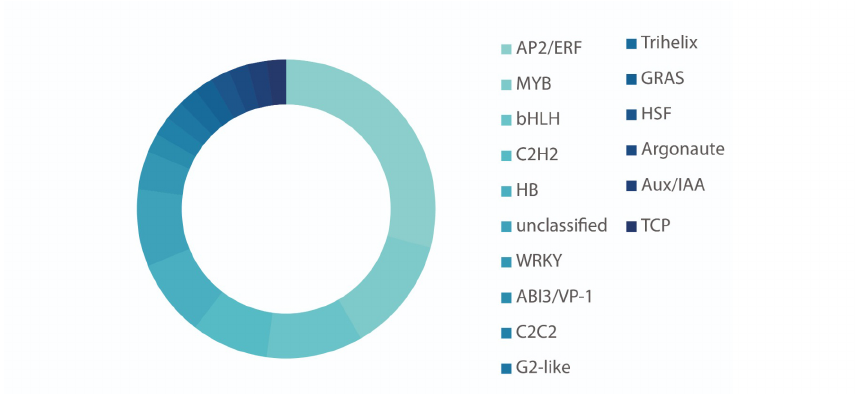
Figure 3. Differentially expressed transcription factor classes in ami1-2 mutants according to Pérez et al. (2021) [37], based on an adjusted p -value of <0.05 and a fold-change of ≥